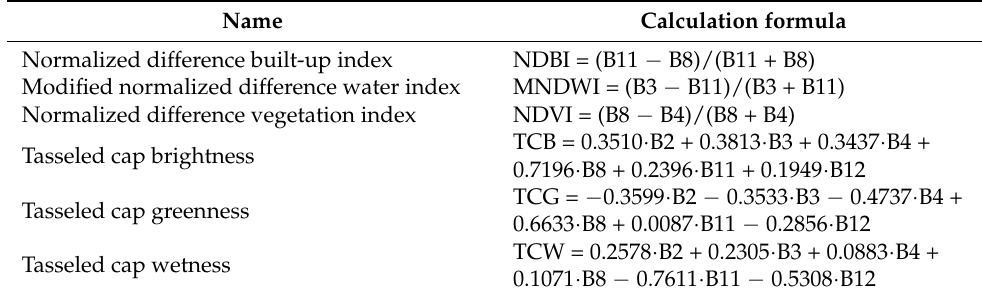
Table 4. Name and calculation formula of spectral indices used in this article.